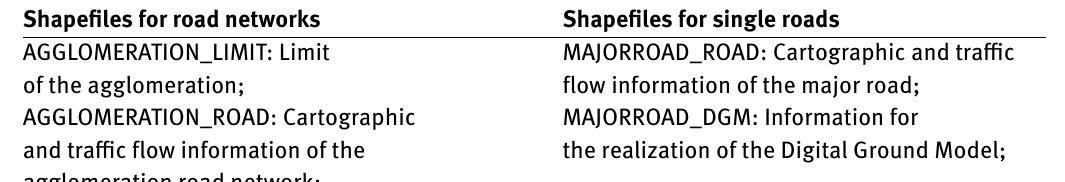
Table 2: List of the shapefiles requested by D2 procedure